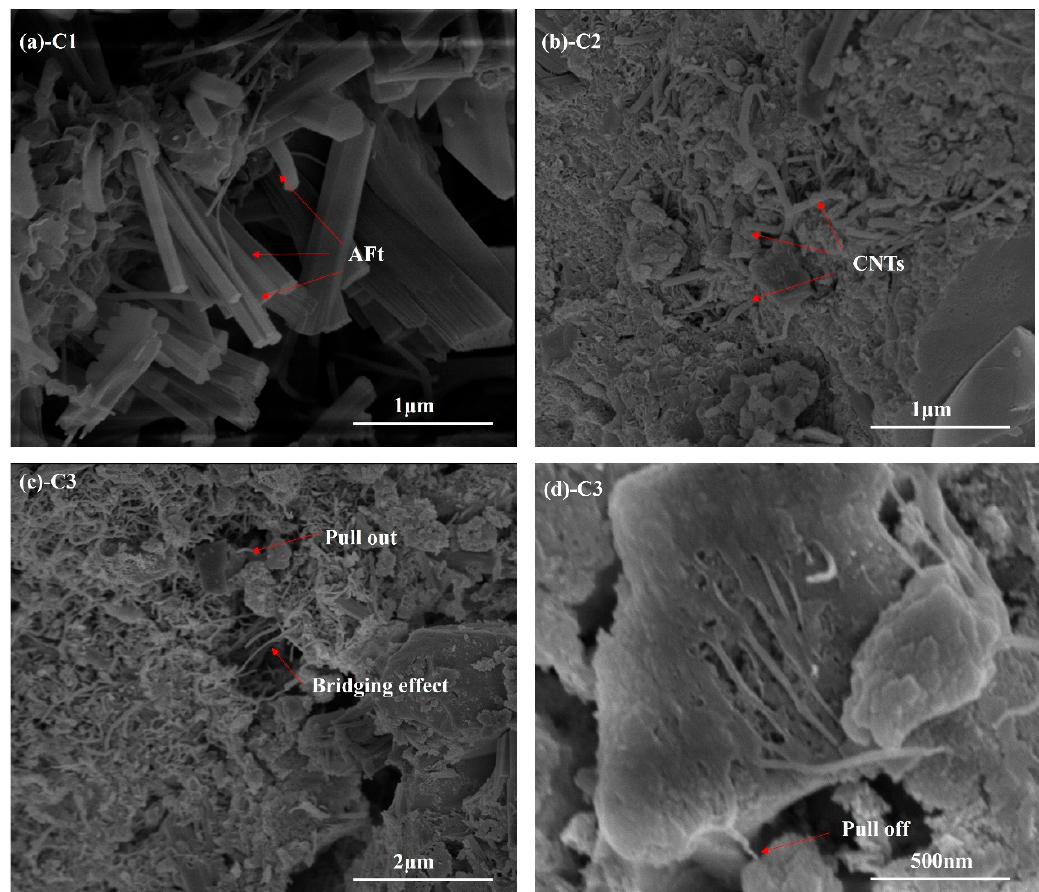
Figure 10. SEM observation of SAC